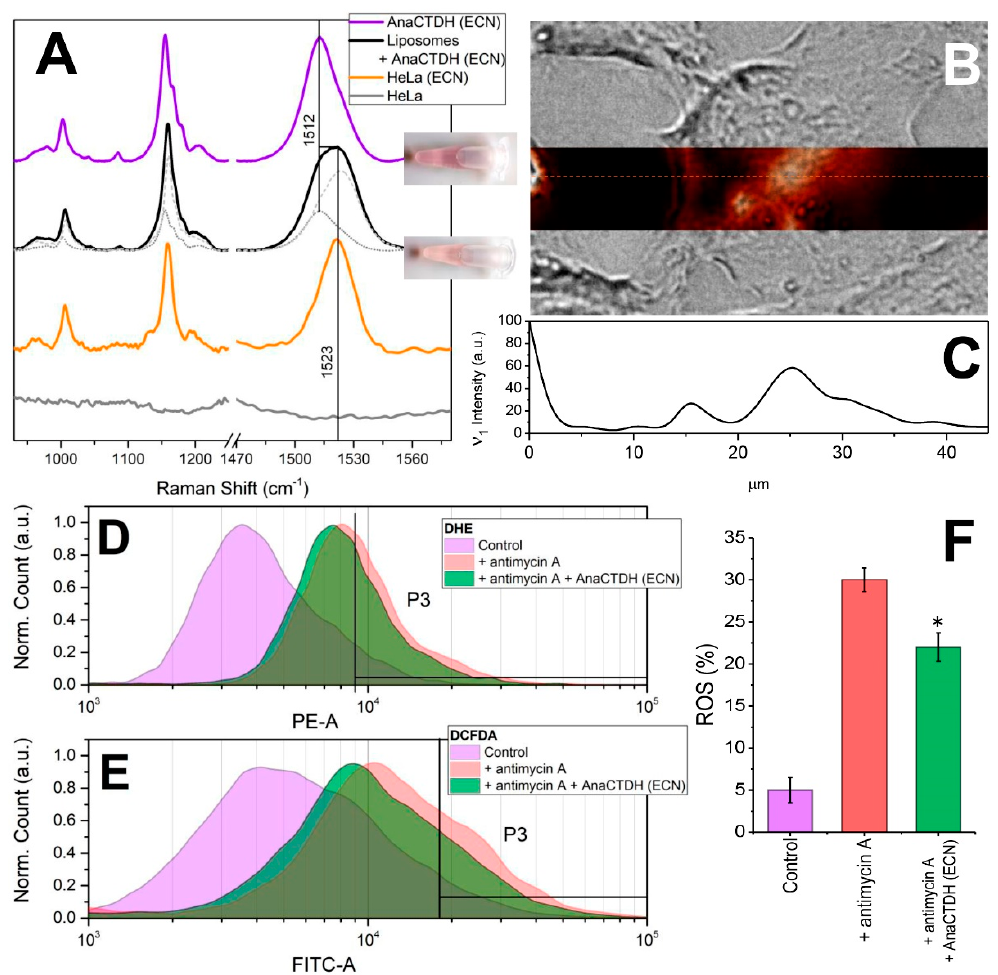
Figure 5. Carotenoid delivery by AnaCTDH(ECN) to mammalian cells. ( A ) Raman spectra of ECN in AnaCTDH (ECN) (violet) and in liposome suspensions after incubation with AnaCTDH (ECN) (black). The spectrum was decomposed into a linear combination of Raman spectra of ECN in AnaCTDH (ECN) (30%) and in liposomes (70%) (see Figure A1). The orange line shows characteristic Raman spectra of ECN in HeLa cells. The grey line shows Raman spectrum of HeLa cells before incubation with AnaCTDH(ECN), with no bands in the carotenoid region observed. The inset shows a tube with a suspension of HeLa cells containing 5 µ M of AnaCTDH(ECN) before (top) and after two hours of incubation (bottom) at 37 ◦ C. ( B ) Overlay of microscopic images of a typical HeLa cell in transmitted light with the of ν 1 band intensity (at 1522 cm − 1 minus background at 1550 cm − 1 ) presented in pseudo colors. The dotted line shows a cross section through the Raman image, the corresponding distribution of the ν 1 band signature (intensity at 1522 cm − 1 minus background at 1550 cm − 1 ) is shown in ( C ). E ff ect of carotenoid delivery by AnaCTDH(ECN) into Tet21N cells on ROS production induced by antimycin A was determined by the fluorescence of the dyes DHE ( D ) and DCFDA ( E ) followed by flow cytometry. ( F ) The yield of ROS in Tet21N cells (purple, control sample), under oxidative stress induced by antimycin A treatment (red) and in cells pre-incubated with CTDH (ECN) and treated by antimycin A (green). Values are presented as mean and standard deviation. * indicates significance at the level of p < 0.05 compared with cells exposed to antimycin A only (statistical analysis performed with the t-Student’s test at significance level of 5%).